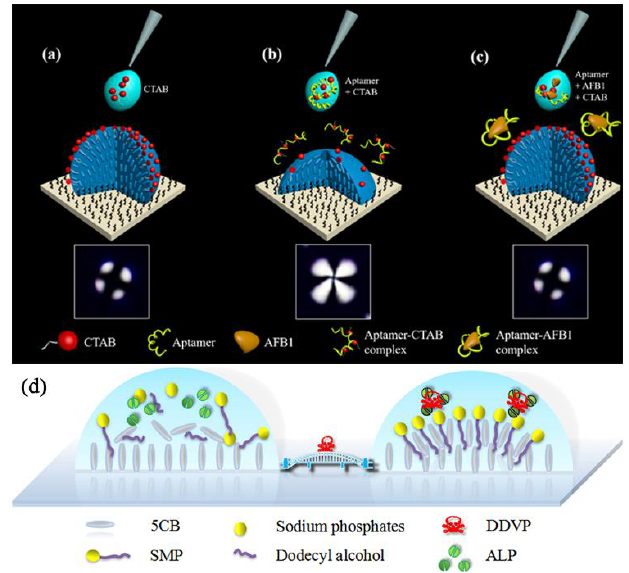
Figure 11. Schematic diagram of the experimental principle. The POM images of the 5CB SADrop and their corresponding configurations in the aqueous solutions of ( a ) CTAB, ( b ) CTAB and AFB1 aptamer, and ( c ) CTAB, AFB1 aptamer, and AFB1, respectively. The dark cross appearance and the four-leaf clover appearance correspond to the radial and escape-radial configurations of LC droplets, respectively. Reprinted with permission from ref. [172]. Copyright 2022 Elsevier. ( d ) Schematic illustration of orientation states for LCs: the absence and presence of DDVP in ALP solution on the SMP doped-5CB droplet patterns. Reprinted with permission from ref. [178]. Copyright 2018 Elsevier.